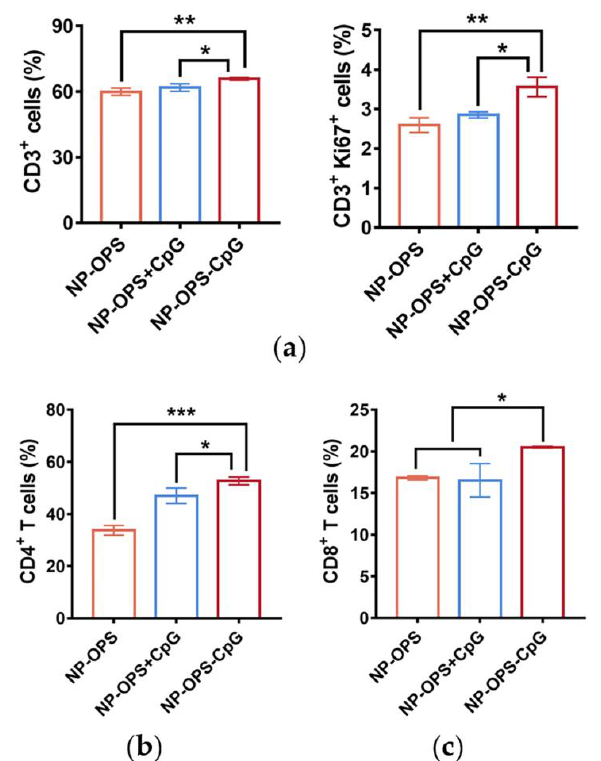
Figure 5. T cell immune responses induced by NP-OPS-CpG in vivo. ( a ) NP-OPS, NP-OPS+CpG, and NP-OPS-CpG were injected into the tail base of mice separately (n = 3). Lymph nodes were obtained from mice three days after immunization, and CD3 + and CD3 + Ki67 + cells were analyzed by flow cytometry. ( b , c ) NP-OPS, NP-OPS+CpG, and NP-OPS-CpG were injected into the tail base of mice separately (n = 3). Lymph nodes were obtained from mice five days after the third immunization, and CD4 + ( b ) and CD8 + ( c ) cells were analyzed by flow cytometry (n = 3). Each group was compared with NP-OPS-CpG using one-way ANOVA: *** p < 0.001; ** p < 0.001, and * p < 0.05.